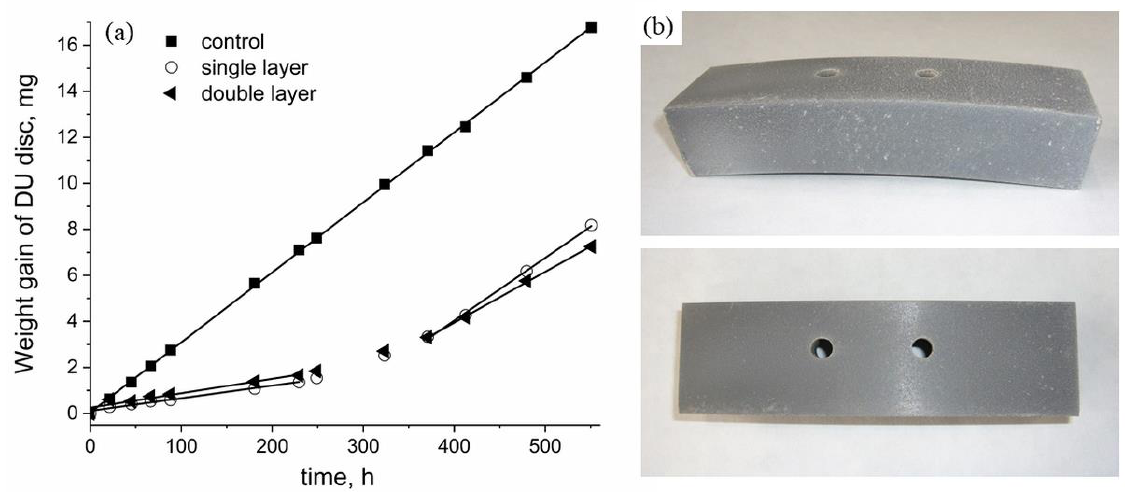
Figure 6. Increase in DU disc weight with time at 115 °C and ambient atmosphere ( a ); prototype DU construction part coated with lead zinc phosphate enamel ( b ). Reprinted with permission from [35]. 2020, Czech Chemical Society.